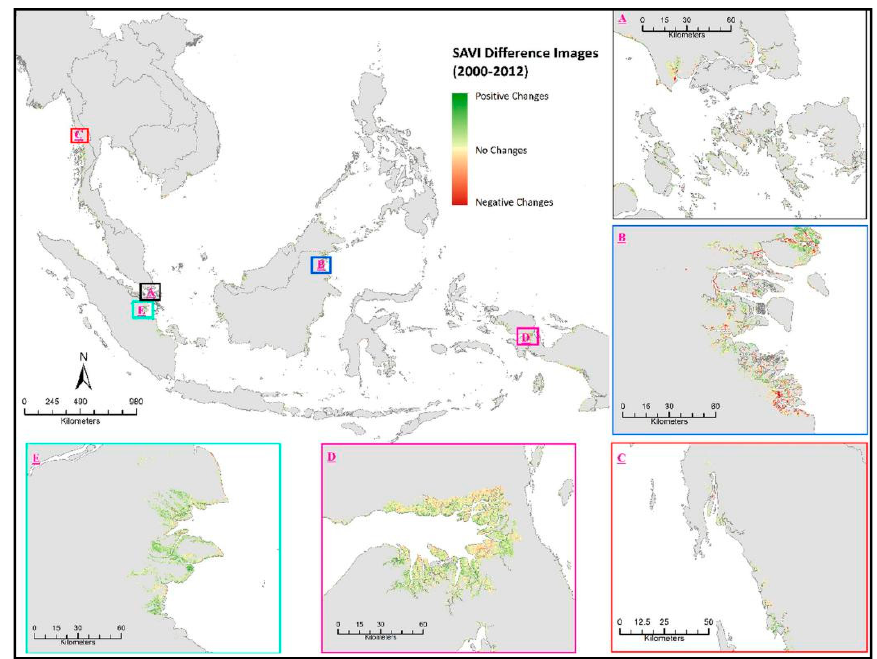
Figure 5. SAVI changes between 2000 and 2012 in mangrove areas. (A) SAVI decrease in Singapore. (B) SAVI decrease in North Kalimantan. (C) SAVI decrease in West Thailand. (D) SAVI increase in West Papua. (E) SAVI increase in South Sumatra.